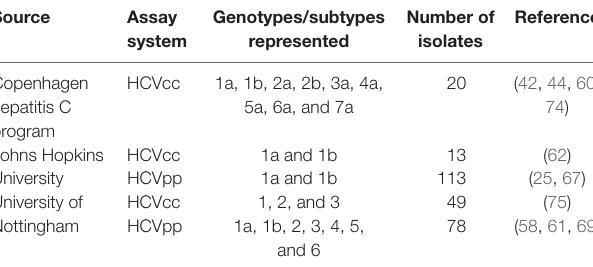
TABLe 1 | HCV cell culture (HCVcc) and HCV pseudoparticle (HCVpp) panels for neutralization breadth